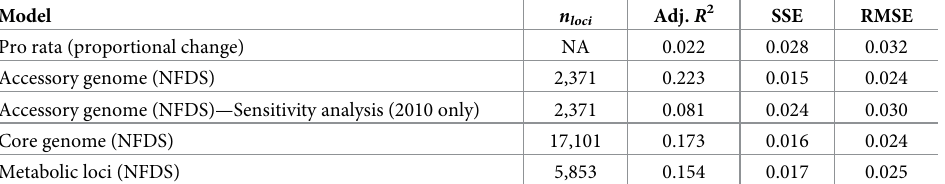
Table 1. Comparison of pre- to post-vaccine prevalence change predictions using multiple models. Model n loci Adj. R 2 SSE RMSE Pro rata (proportional change) NA 0.022 0.028 0.032 Accessory genome (NFDS) 2,371 0.223 0.015 0.024 Accessory genome (NFDS)—Sensitivity analysis (2010 only) 2,371 0.081 0.024 0.030 Core genome (NFDS) 17,101 0.173 0.016 0.024 Metabolic loci (NFDS) 5,853 0.154 0.017 0.025 Goodness-of-fit statistics including SSE, RMSE, and degrees of freedom Adj. R 2 are given for each model in relation to the 1:1 line. Fit statistics are provided for the naive pro rata model and quadratic programming models using accessory genes, 5,853 biallelic polymorphic nucleotide sites found in 272 core genome metabolic genes, and 17,101 biallelic polymorphic nucleotide sites found in 1,111 core genes. The results of the sensitivity analysis using a subsample of 119 isolates collected in 2010 prior to the initiation of PCV13 vaccine introduction is also presented for the